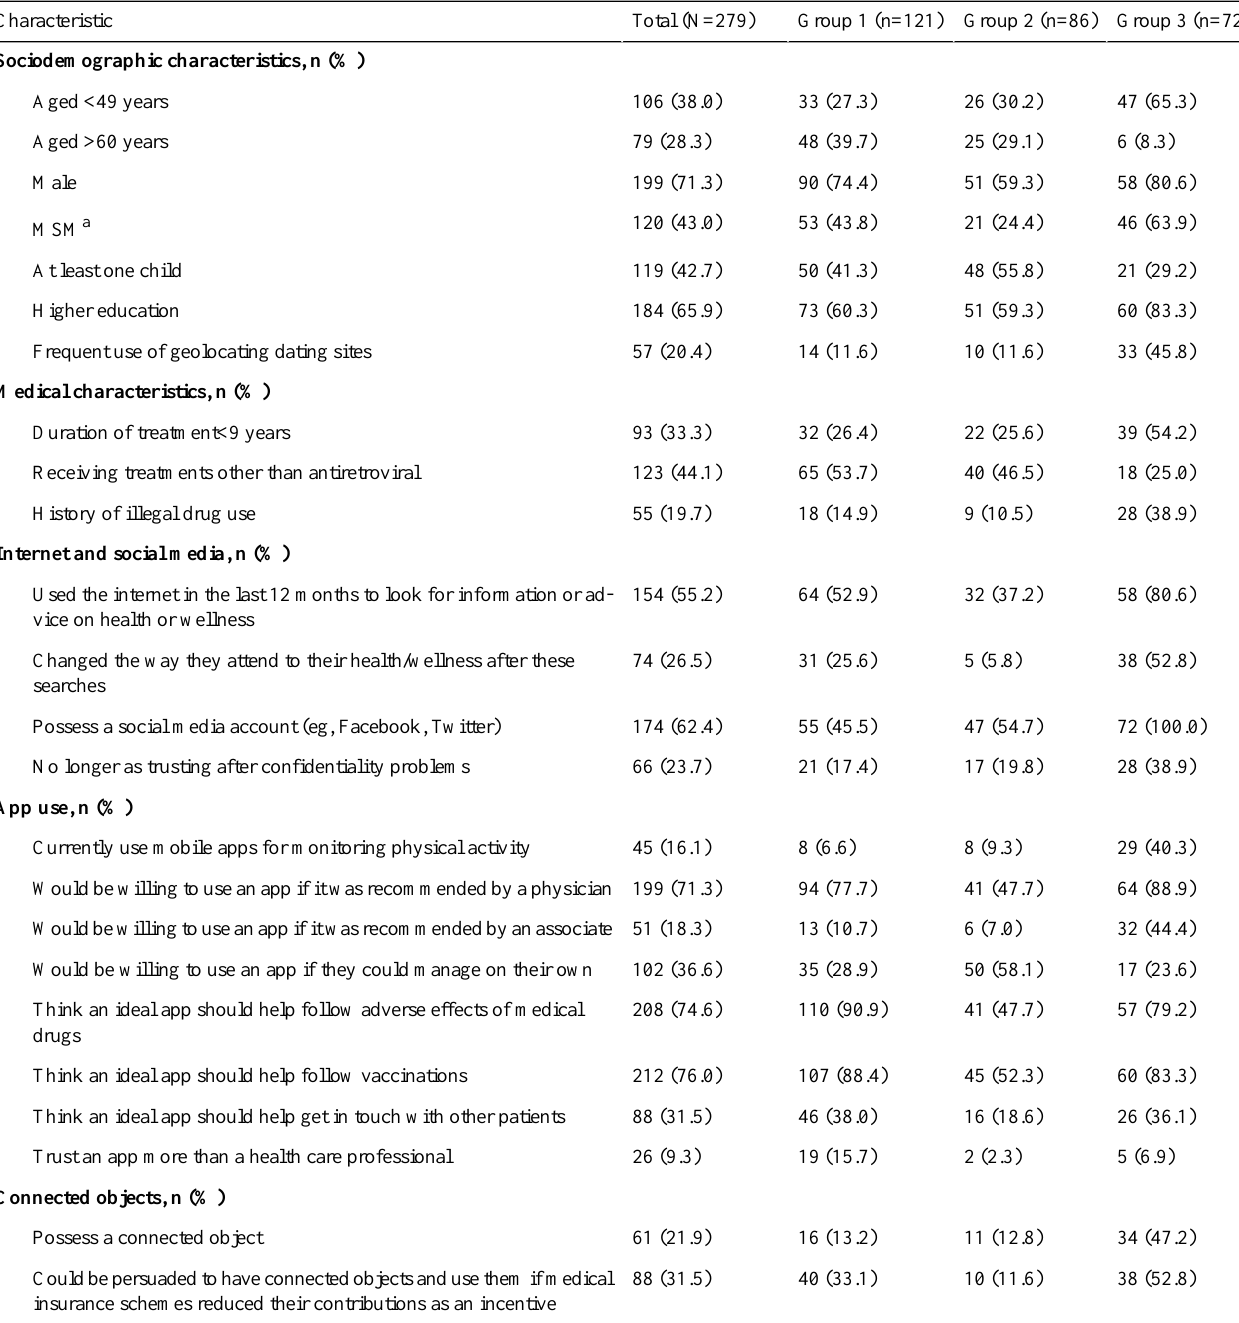
Table 4. Sociodemographic and medical characteristics, internet and social media, app use, and connected objects for three groups of people living with HIV obtained by mixed unsupervised